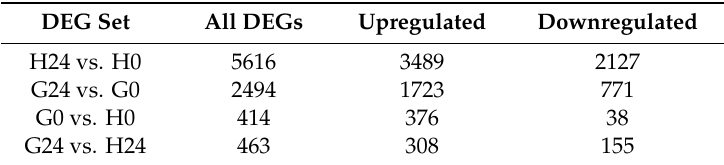
Table 1. Comparison of the number of transcripts identified in the DEGs. DEG Set All DEGs Upregulated Downregulated H24 vs. H0 5616 3489 2127 G24 vs. G0 2494 1723 771 G0 vs. H0 414 376 38 G24 vs. H24 463 308